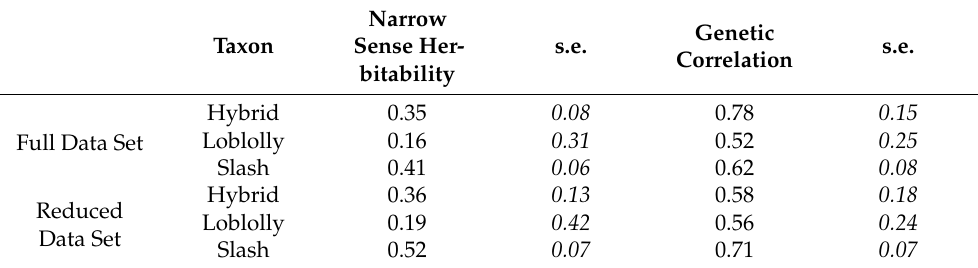
Table 3. Estimates of narrow-sense individual tree heritability with standard errors and genetic correlations. Heritability was estimated following Equation (2). Genetic correlation is estimated directly in ASReml as a linear combination of the intra-taxon additive variances at each of the isolates and common intra-taxon covariance.